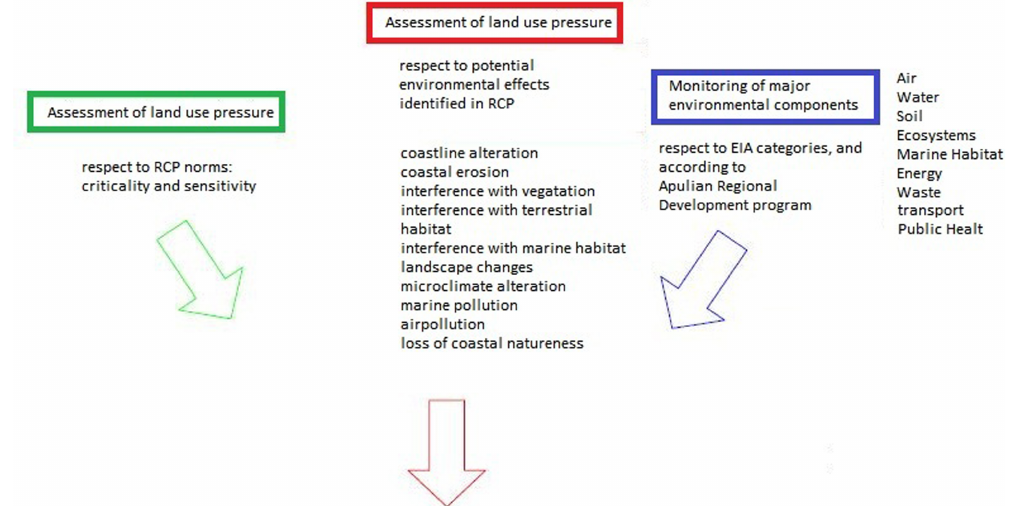
Fig. 5. The integrated process of